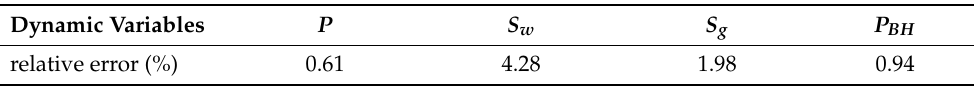
Figure 11. The relative errors of the prediction RE prediction of all the wells. Table 5. The relative errors of the dynamic variables RE dyn at the last assimilation step with un- known